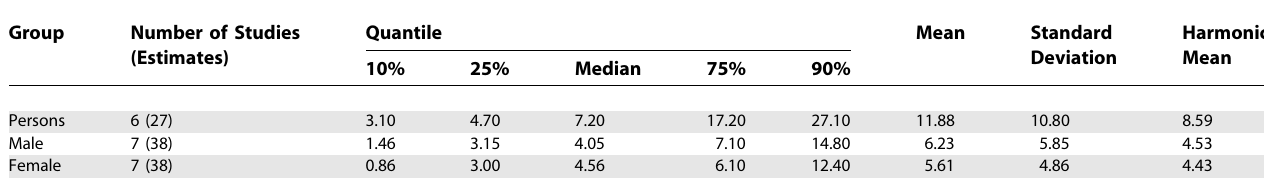
Table 6. Quantiles and Moments of Studies with LMR per 1,000 by Sex Group Number of Studies (Estimates)